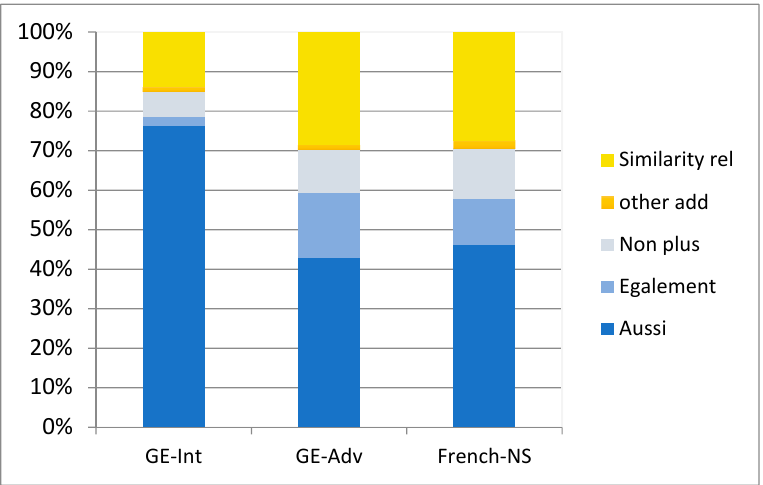
Figure 3. Proportion of means used in French L2 in the additive contexts.